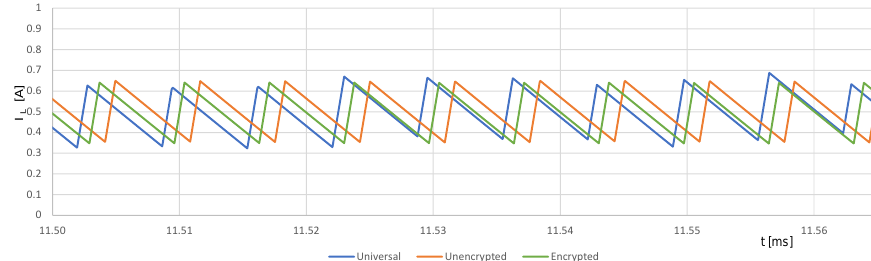
Figure 29. I L time graph curves using LM2594 regulator.